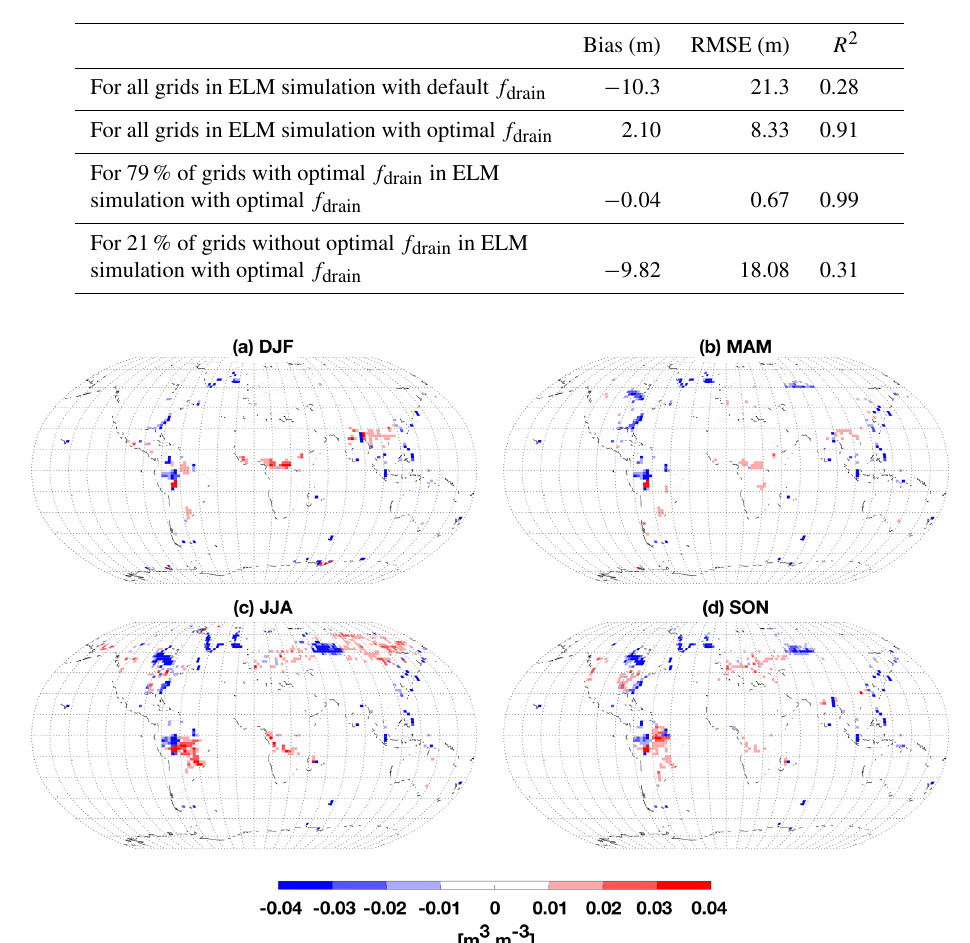
Figure 8. Seasonal monthly mean soil moisture differences for top 10cm between ELMv1-VSFM simulations with optimal and default f d